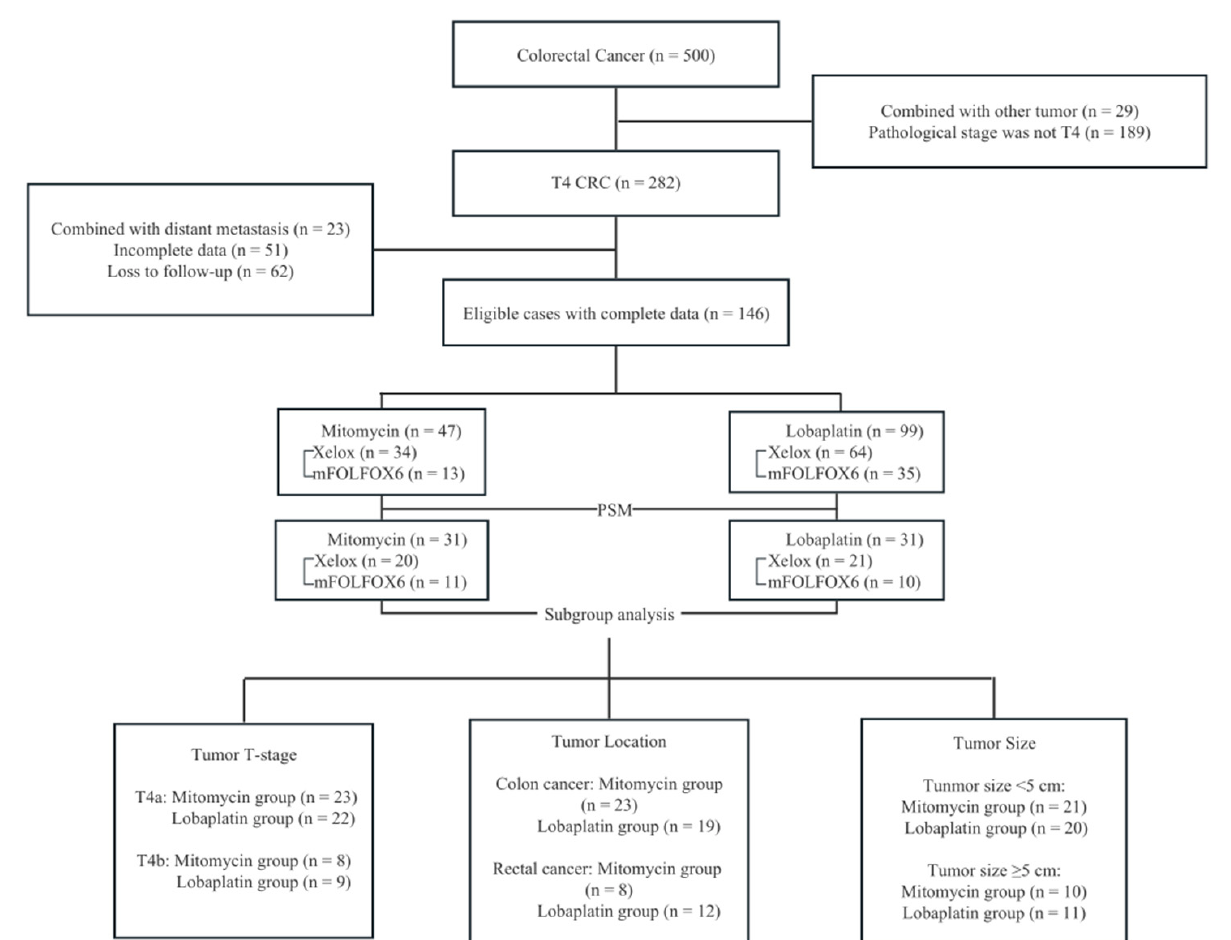
Figure 2. Flow chart. A total of 146 out of 500 T4 CRC patients were included in the study. Inclusion criteria: (1) It was con fi rmed by postoperative pathology as advanced colorectal adenocarcinoma